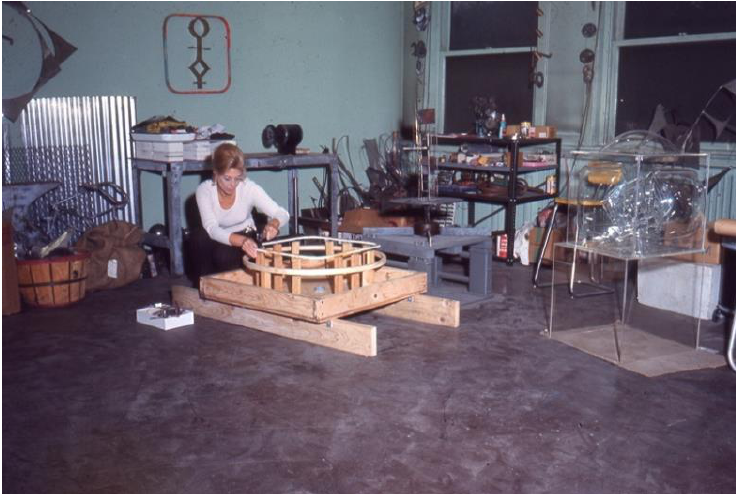
Figure 2 Photographer unknown, Artist Aaronel deRoy Gruber preparing custom wood framework and molds in her studio at Engineered Products Inc., Pittsburgh, PA ., approximately 1970. Digitized photograph. Image courtesy of the Irving and Aaronel deRoy Gruber Foundation,